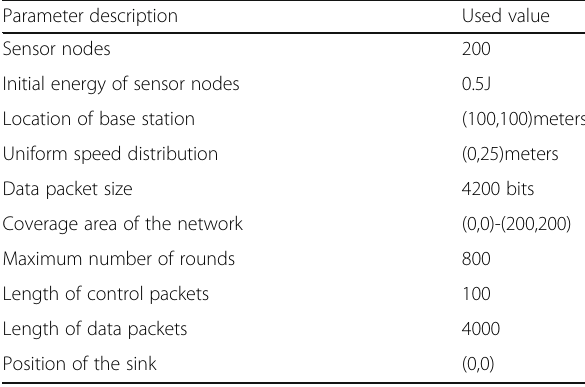
Table 2 Simulation parameters for SMPISCS